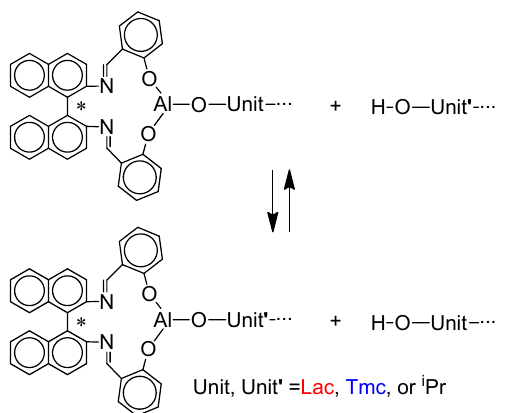
Scheme 6. Chain-transfer reactions operating in the studied copolymerization systems. Due to the assumption of instantaneous initiation isopropyl ( i Pr) containing active species, as well as i PrOH, coming from the in situ synthesis of Ini (cf. Scheme 3), could be neglected.